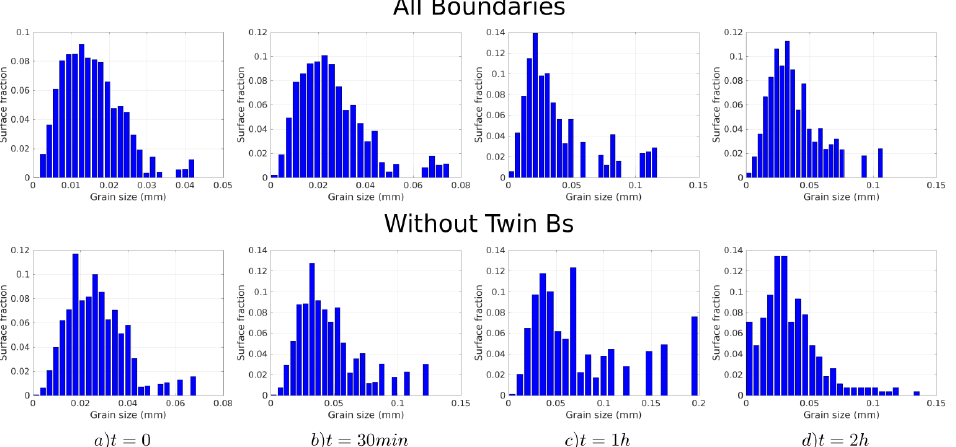
Figure 5. From left to right: evolution of the grain size histograms (in surface) at t = 0 s, t = 30 min, t = 1 h, and t = 2 h. ( Top ): All boundaries are considered. ( Bottom ): Σ 3 twin boundaries are